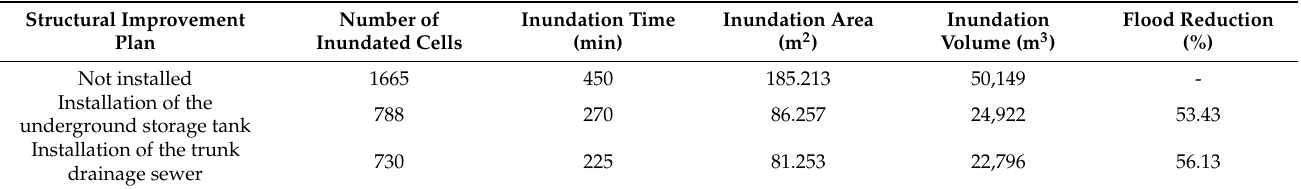
Table 5. Flood analysis according to the reduction facility installation conditions (Gunja